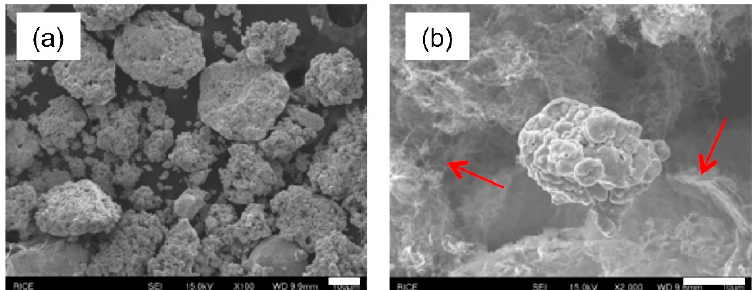
Figure 6. SEM images of ( a ) copper micropowder and ( b ) a physical mixture of copper micropowder with HiPCO SWCNTs. SWCNTs are seen in ( b ) as highly bundled species segregated into domains (indicated by the arrows) among the copper particles suggesting poor mixing. Scale bar = 100 μ m ( a ) and 10 μ m ( b ).